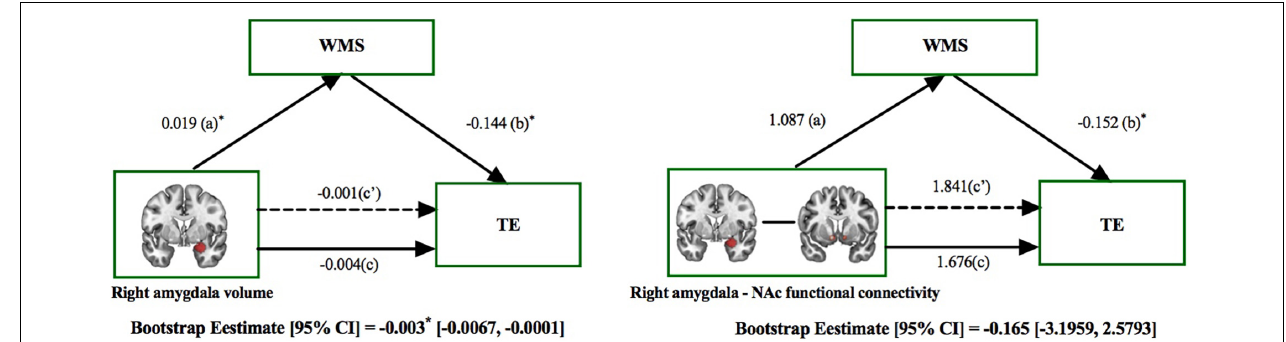
FIGURE 6 | The mediating role of memory ability on the effect that right amygdala had on treatment efficacy. The mediation model included right amygdala features (subcortical volume and functional connectivity) as the independent variable, the effects on treatment efficacy (HAMD baseline –HAMD 4 − week / 8 − week ) as the dependent variable, and the effects on memory ability [assessed by Wechsler Memory Scale (WMS)] as the mediator. Left panel: The effect of right amygdala volume on TE was mediated by the WMS. Right panel: The effect of right amygdala and NAc functional connectivity on TE was not mediated by the WMS. ∗ p < 0.05; TE, Treatment